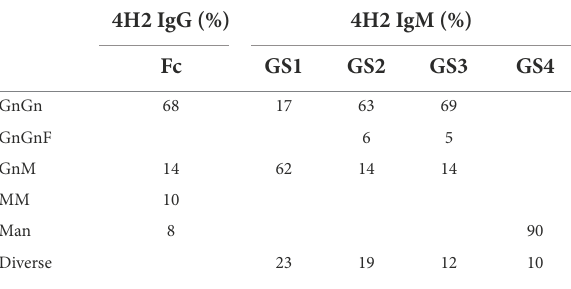
TABLE 1 N-linked glycosylation of 4H2 mAb